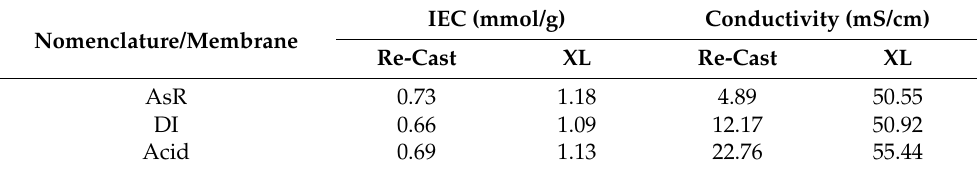
Table 2. IEC and conductivity values for untreated and treated re-cast and Nafion XL membranes.